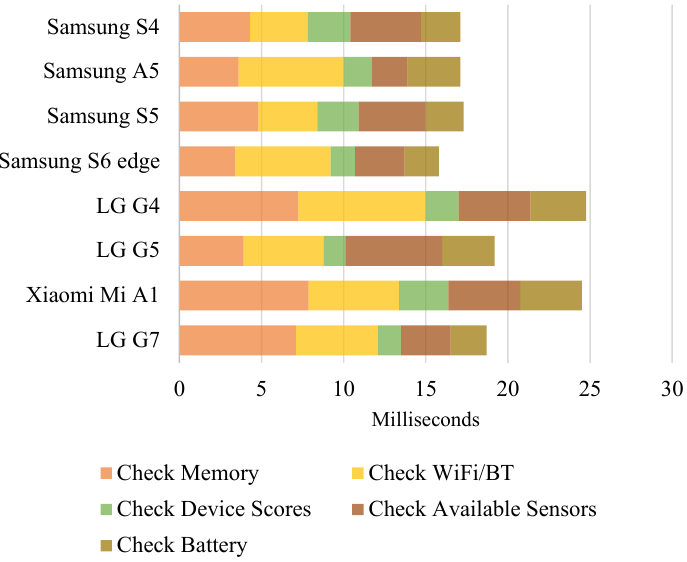
Figure 4. CDP on 8 commercial Android smartphones (lower is better).